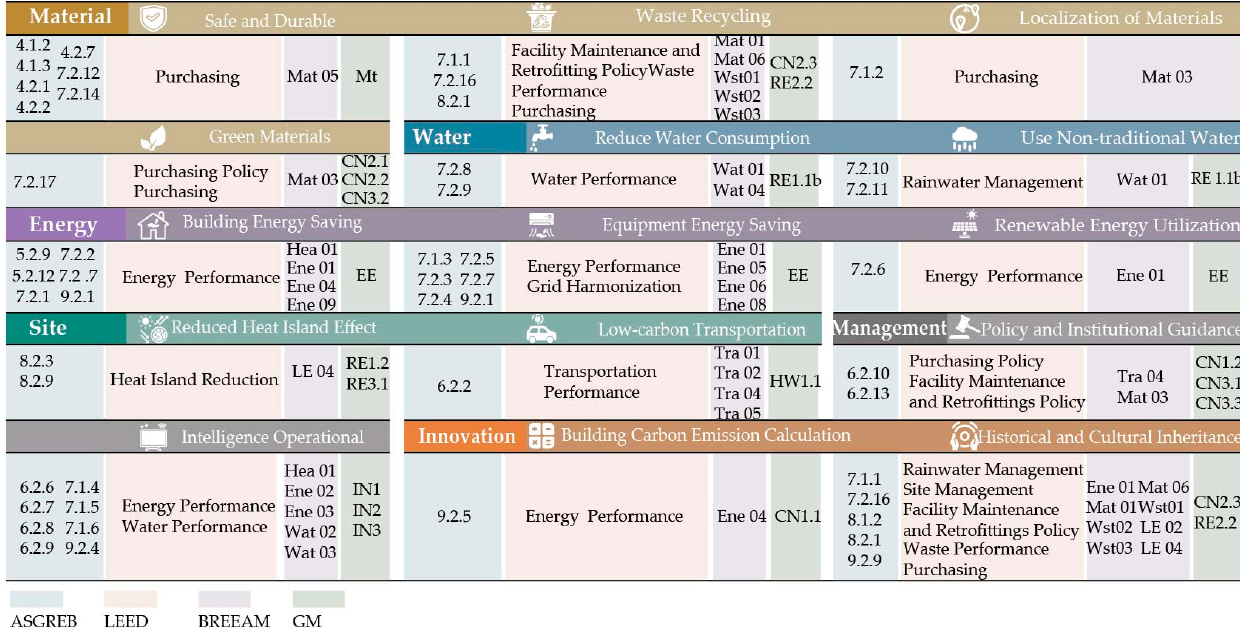
Figure 6. Measures in the GBRS.